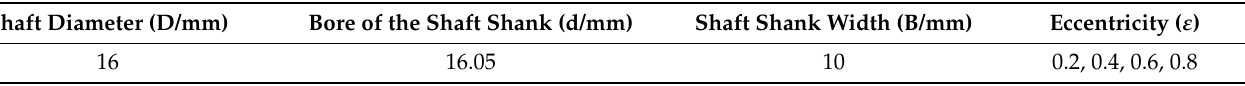
Figure 2. Distribution of magnetic particles with and without a magnetic field: ( a ) without magnetic field; ( b ) with magnetic field. Table 1. Basic parameters of the structure of bearing friction